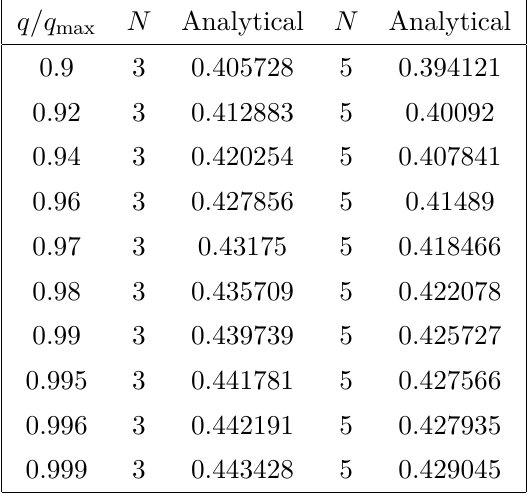
Table 3 . Analytical values of the ratio − ( Im ω/κ − ) have been presented for two different values of the Lovelock order N . Here we have taken the cosmological constant and the mass to read, Λ = − 0 . 1 and M = 1 ,